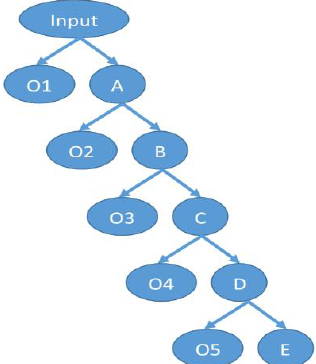
Figure 6. Fuzzy Decision Tree Algorithm for rainfall intensity warning.